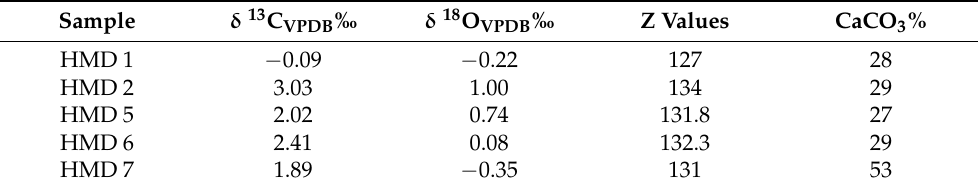
Table 1. The oxygen and carbon stable isotope, Z values and CaCO 3 % content of the Wadi Al-Hamd